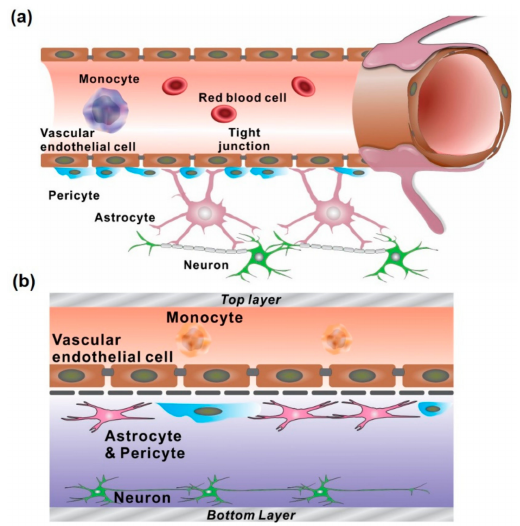
Figure 6. Comparison of the in vivo and in vitro neurovascular unit structure. ( a ) The schematics of the in vivo human neurovascular unit. ( b ) Representative in vitro microfluidic-integrated NVU models with vertically-aligned two microfluidic